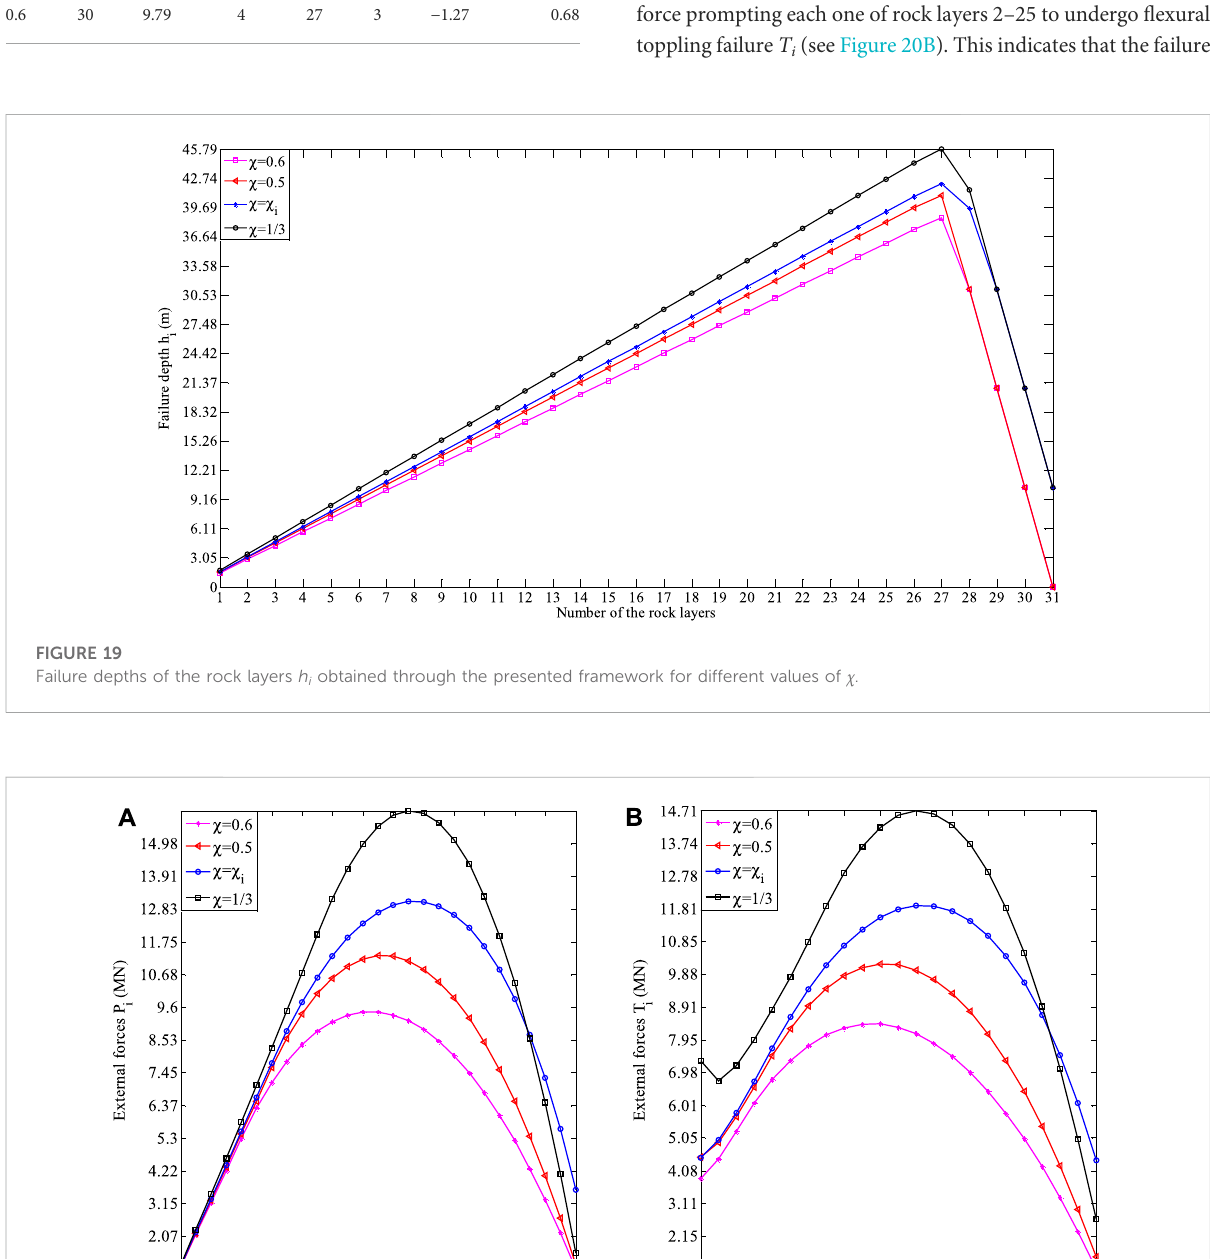
Frontiers in Earth